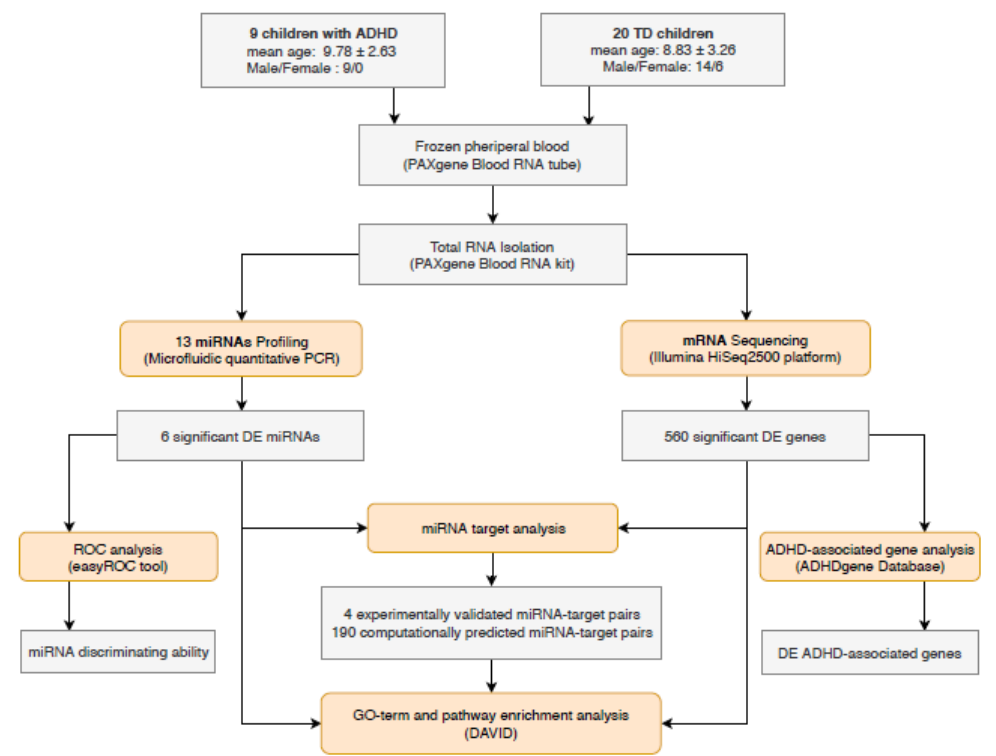
Figure 1. Flow chart describing the study design.